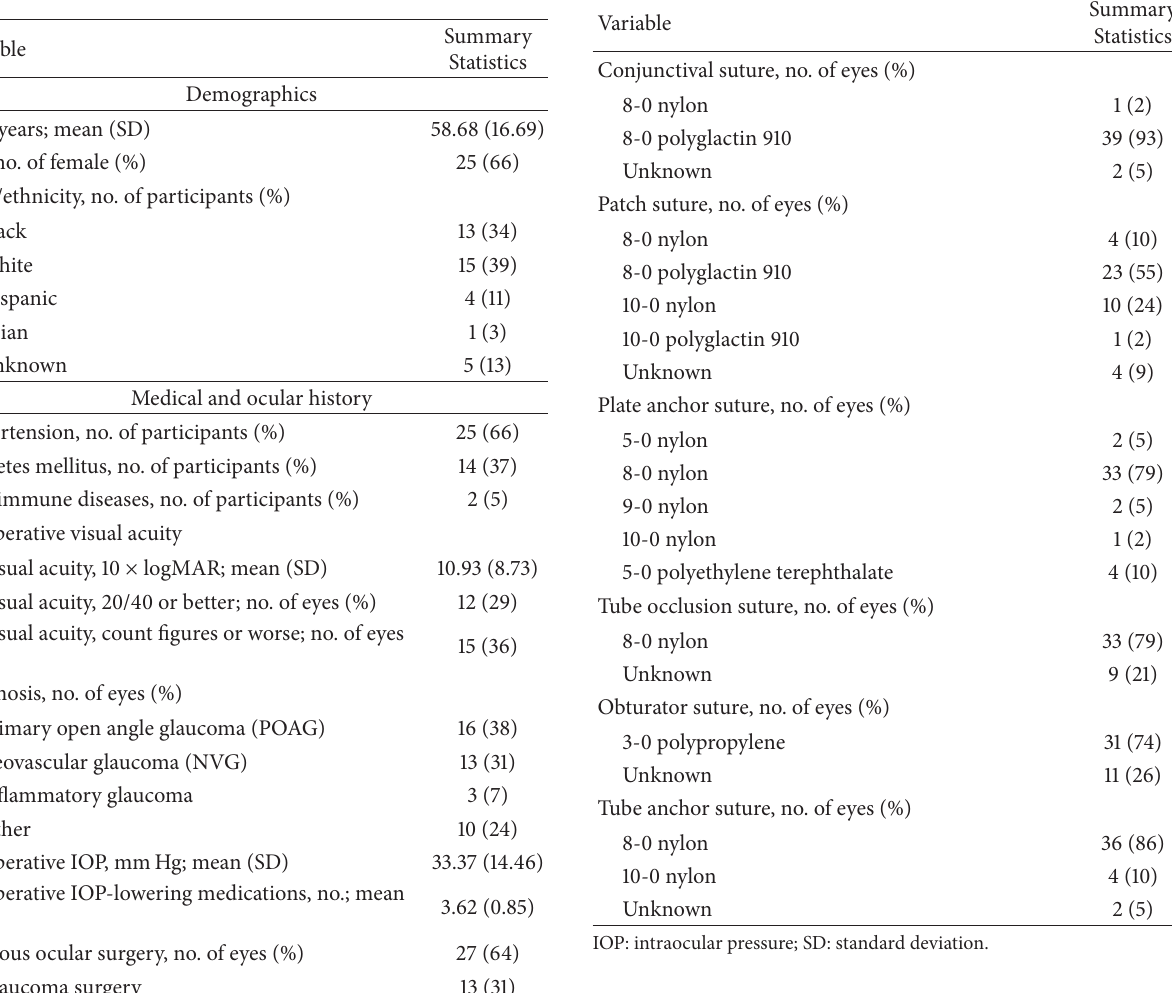
Table 1: Demographics, medical history, and baseline characteris-